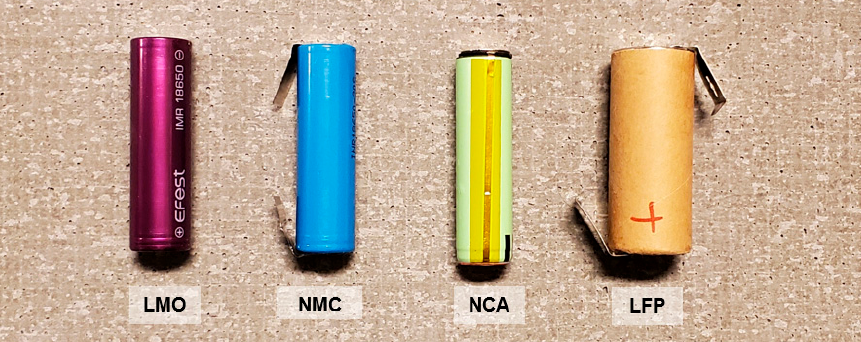
Figure 2. Four lithium-ion battery cells with different chemistries tested in the study.